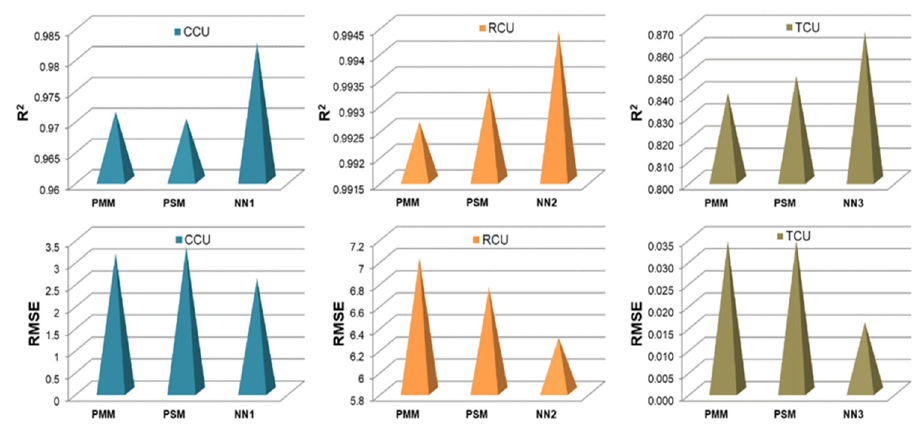
Figure 24. Comparison of fuzzy and ANN modeling results: R 2 and RMSE.